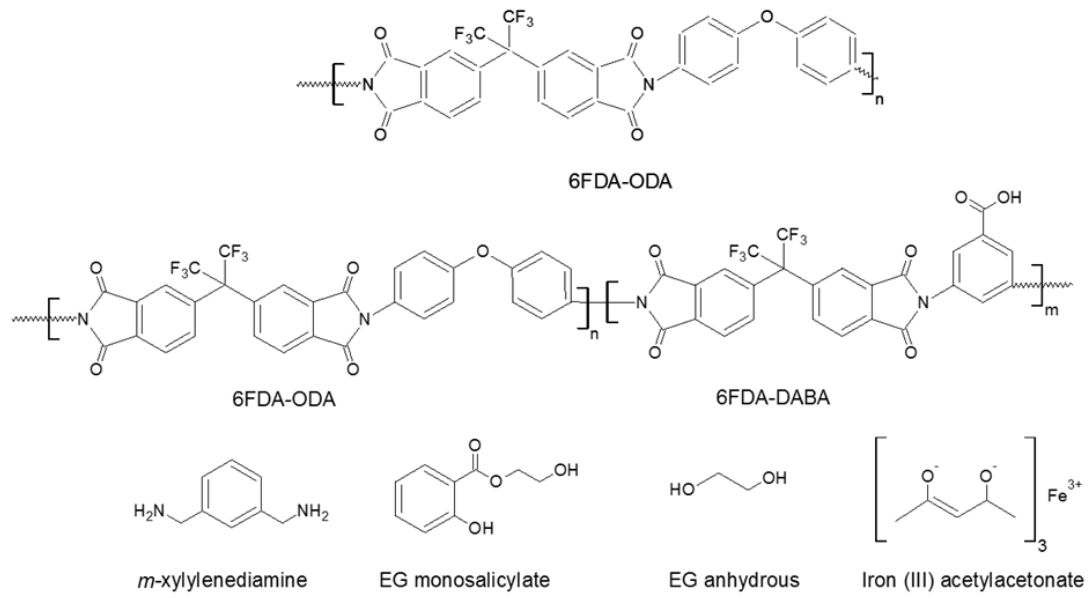
Figure 4. Chemical structures of 6FDA-ODA, 6FDA-ODA:DABA and several of their crosslinking agents in this study. The statistical copolymer of 6FDA-ODA:DABA is 1:X:Y where X = n/(n + m) and Y = m/(n + m).